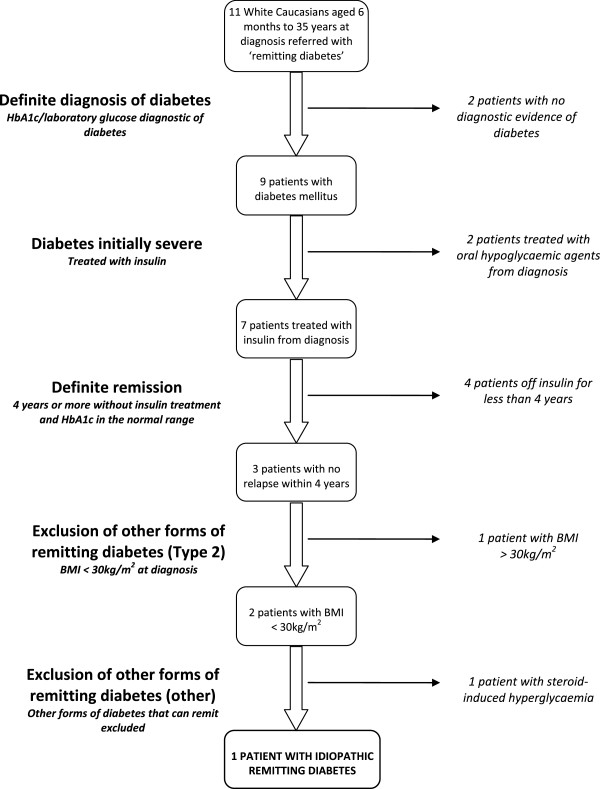
Flow chart showing referrals and the application of diagnostic criteria to diagnose idiopathic remitting diabetes.